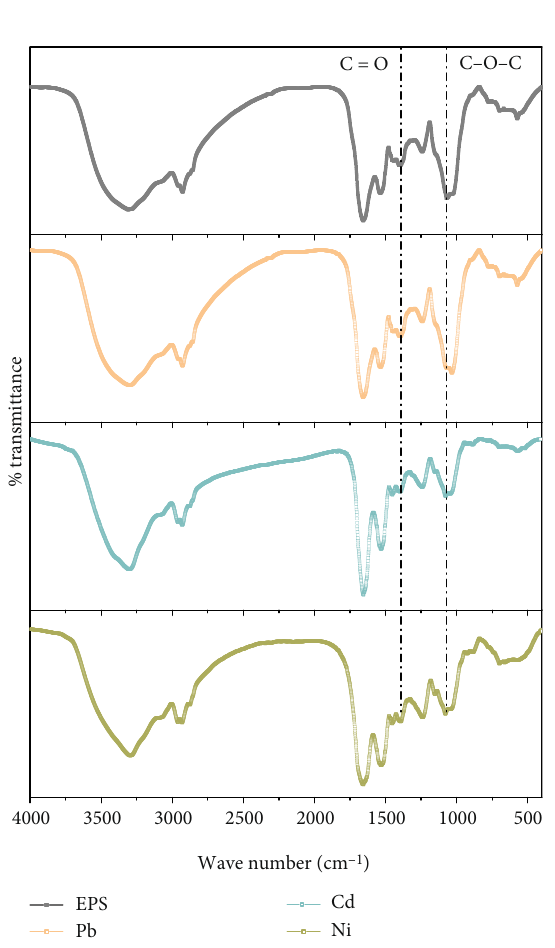
Figure 3: Functional group analysis of EPS before and after Pb 2+ , Cd 2+ , and Ni 2+ adsorption.